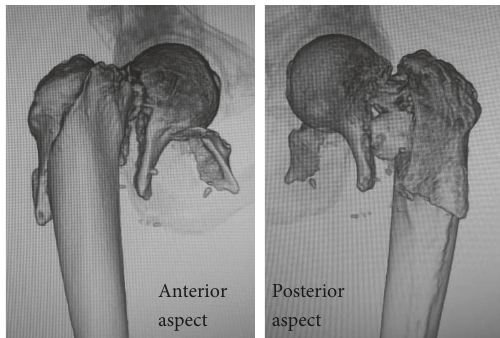
Figure 2: Anterior fracture line and posterior fracture line of Type 1-2-3-4 fractures. Fracture lines are present along the trochanteric fossa to the intertrochantericfossa in the posterior region and below the femoral head in the anterior region.